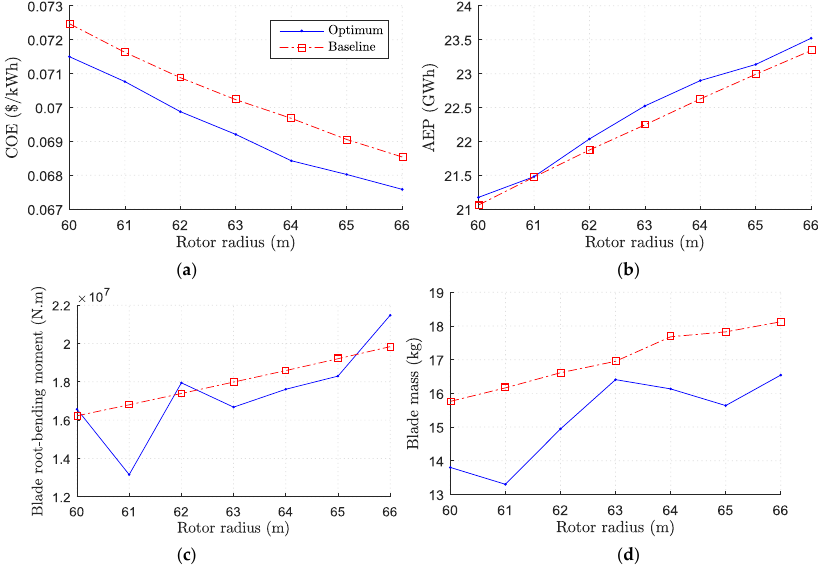
Figure 5. ( a ) Cost of energy; ( b ) annual energy production; ( c ) flap-wise blade root-bending moment; and ( d ) blade mass versus rotor radius.